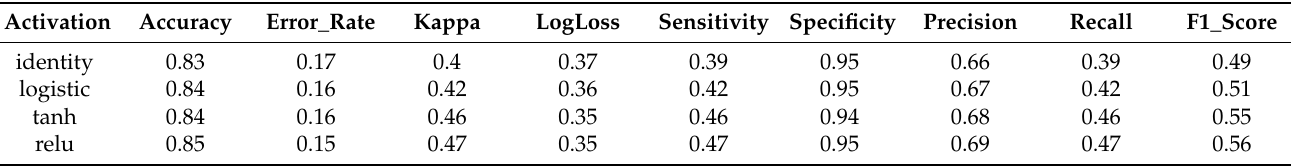
Table 10. Metrics for activation parameter.